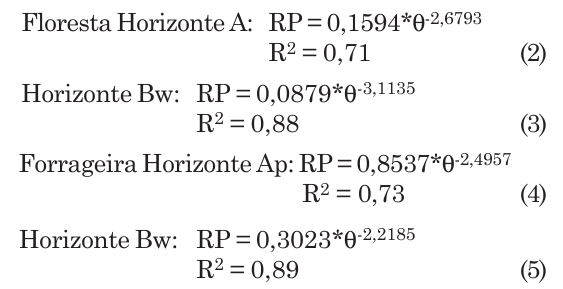
Figura 2. Valores médios de macro, micro e porosidade total dos horizontes A e Bw do Latossolo Vermelho sob forrageira e floresta nativa. Para cada parâmetro, valores seguidos por letras minúsculas diferentes indicam diferenças significativas entre os tratamentos (p < 0,05).